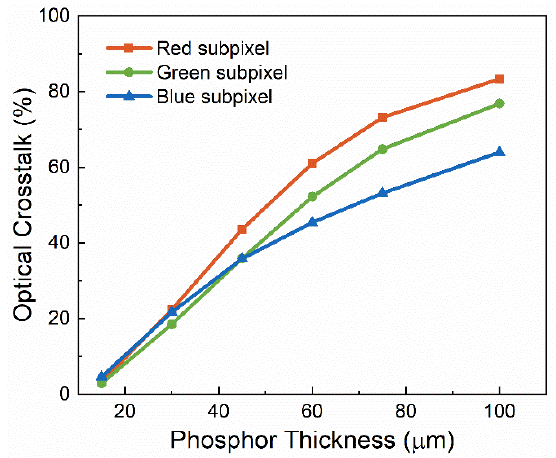
Figure 3. Simulated color crosstalk ratio of device A as a function of phosphor thickness.